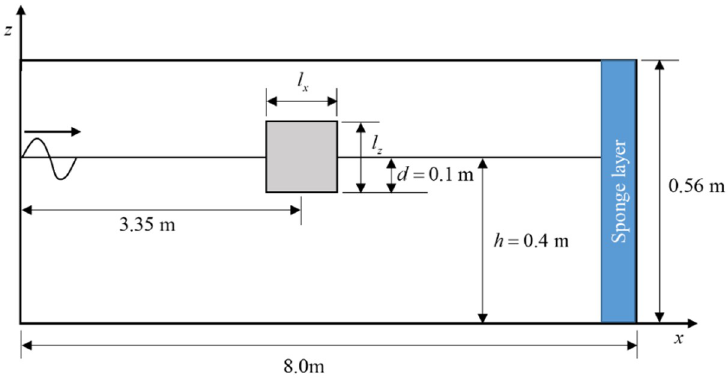
Figure 2. The schematic computational domain for the motions of a free-floating box in waves.